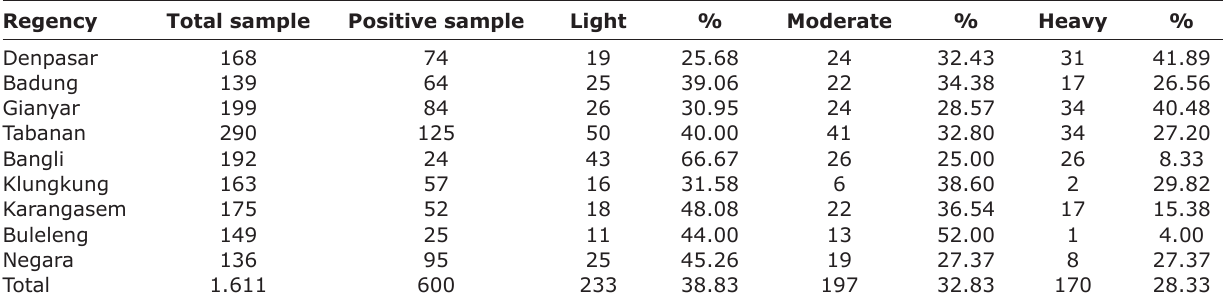
Table-3: The intensity of Ancylostoma spp. infection in free-roam dogs and its distribution in Bali Province. Regency Total sample